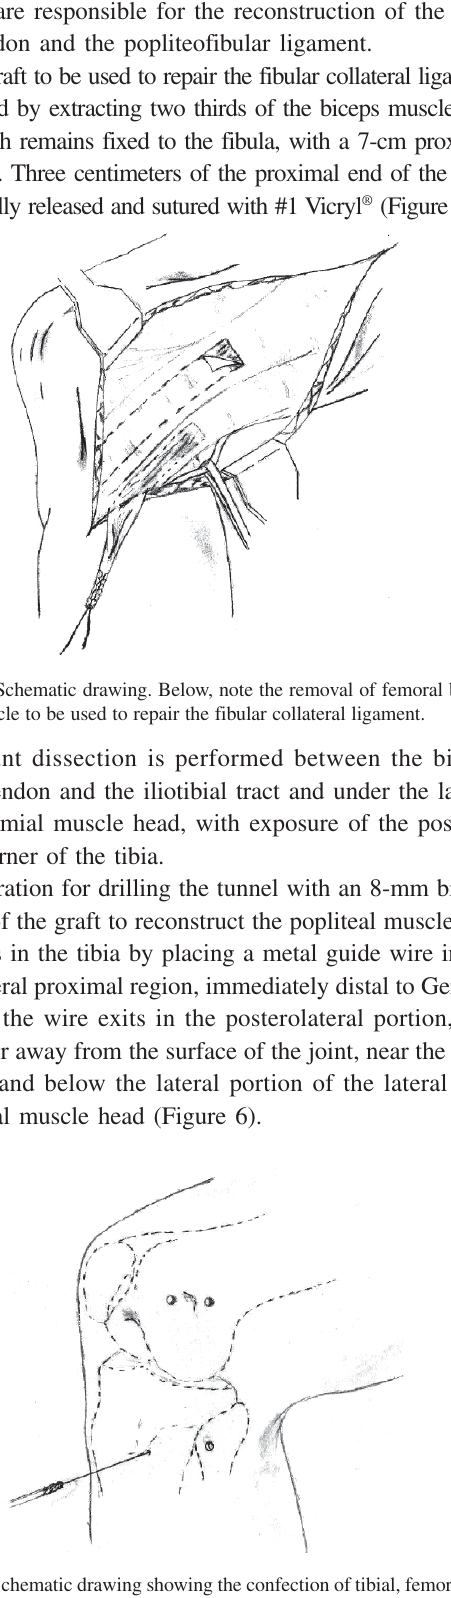
Figure 6 - Schematic drawing showing the confection of tibial, femoral and fibular